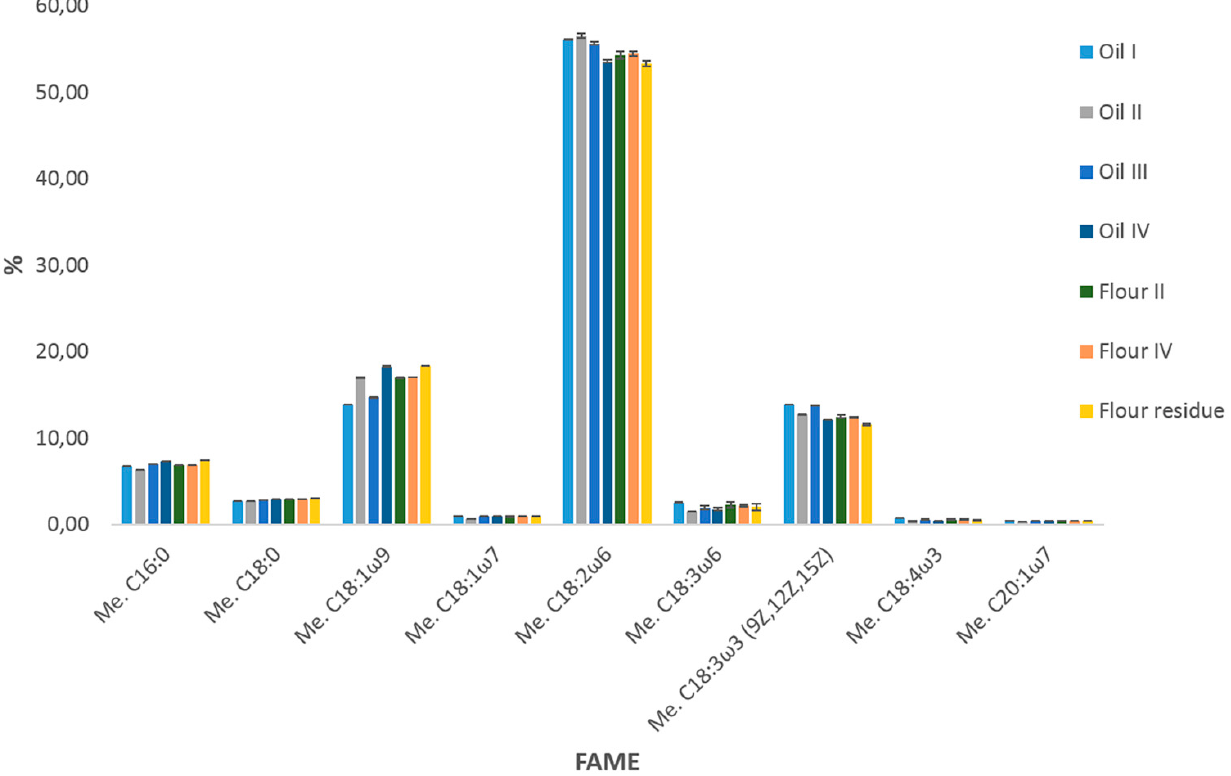
Figure 2. Comparative histogram (% content) of major FAs in the lipid fraction of hempseed products. In particular, lower levels of palmitic and oleic acids were detected in flour IV com- pared to both the oil and the residue ( p < 0.01, by running an ANOVA), offset by a higher level of all the ω 6 and ω 3 FAs ( p < 0.01, by running an ANOVA), thus, justifying the higher total PUFA, ω 6 and ω 3 amounts reported in Table 1. Conversely, flour II resulted as less concentrated for the corresponding oil in linoleic acid ( p < 0.01, by running a two-tailed t -test) and more concentrated in γ -linolenic and stereadonic acid ( p < 0.05, by